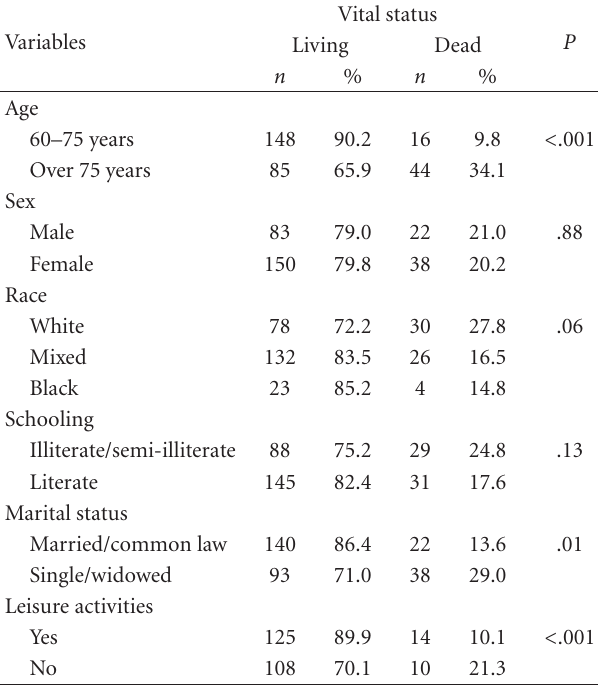
Table 2: Distribution of vital status, according to physical health variables of elderly residents in Santa Cruz,